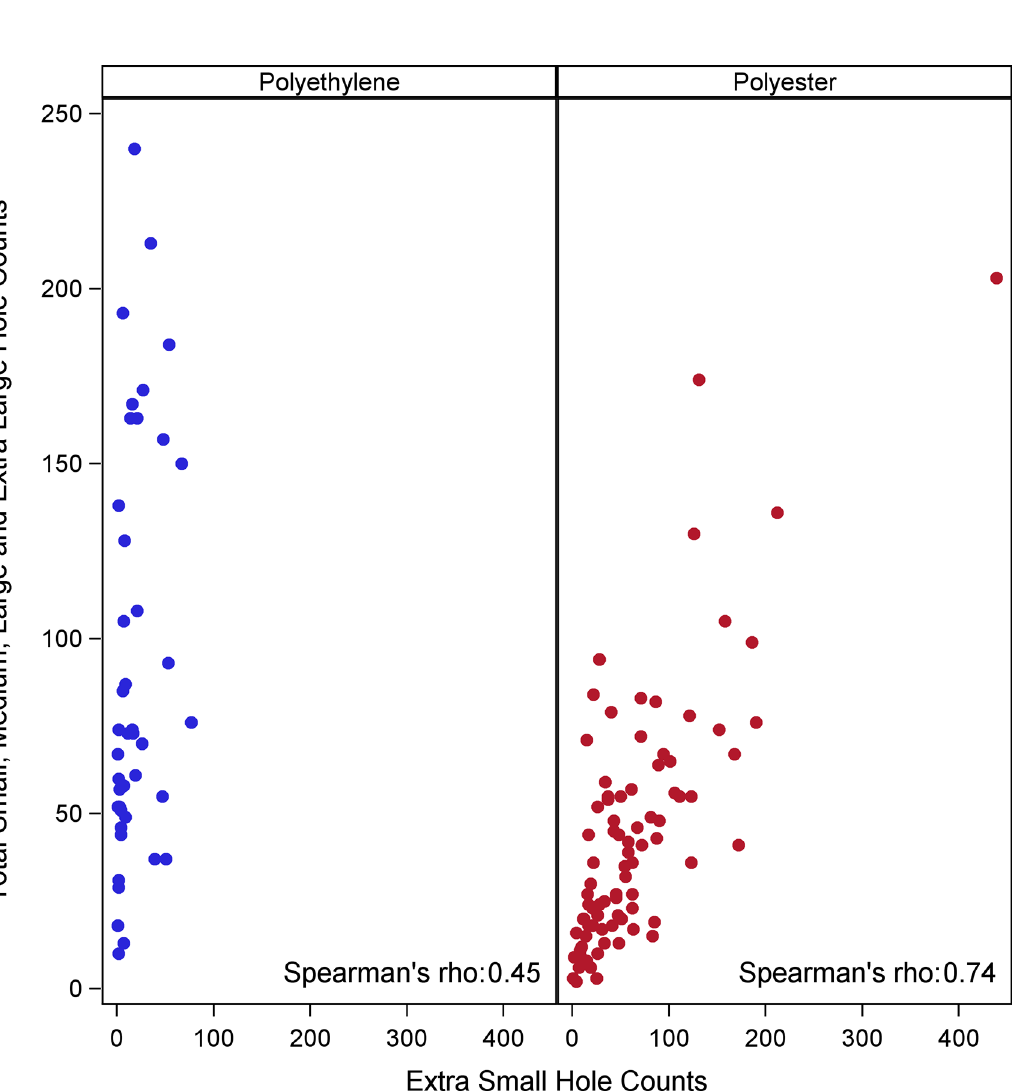
Fig 4. Scatterplots of number of extra-small size holes ( < 0.5 cm) vs total number of small, medium, large and extra-large size holes per net by type for 130 nets during the 3 rd year of study (2011). Each point represents one net. Polyester nets: 100 denier, traverse [3.5.50], Polyethylene nets: 150 denier, tulle [3.5.52].